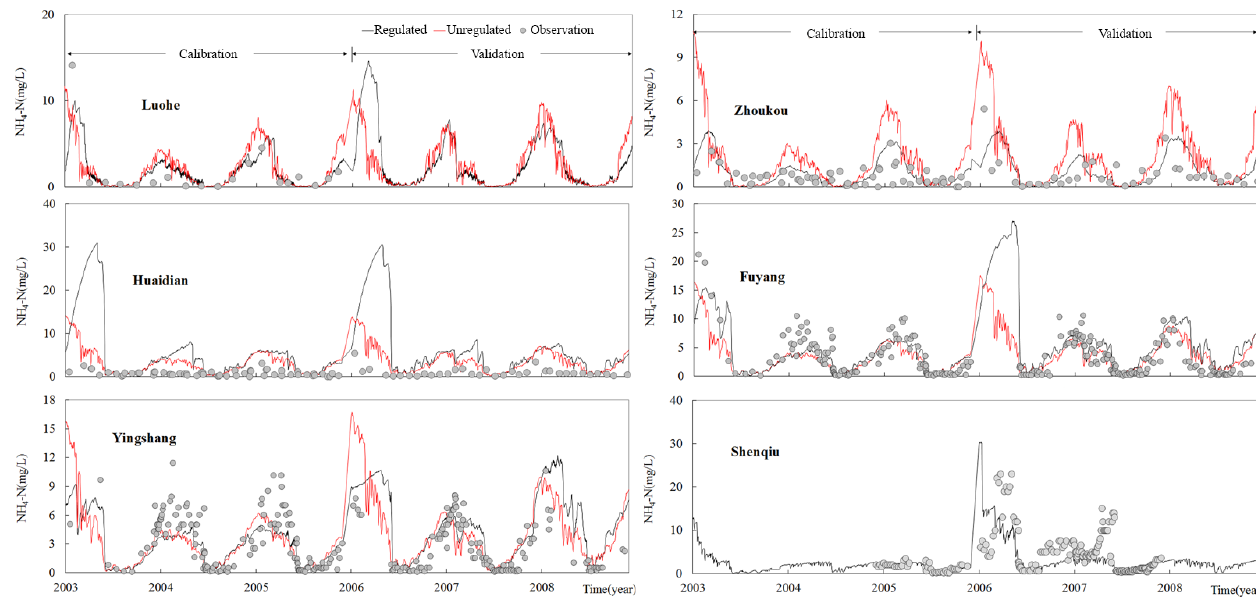
Figure 9. The simulated NH 4 –N concentration variation at all